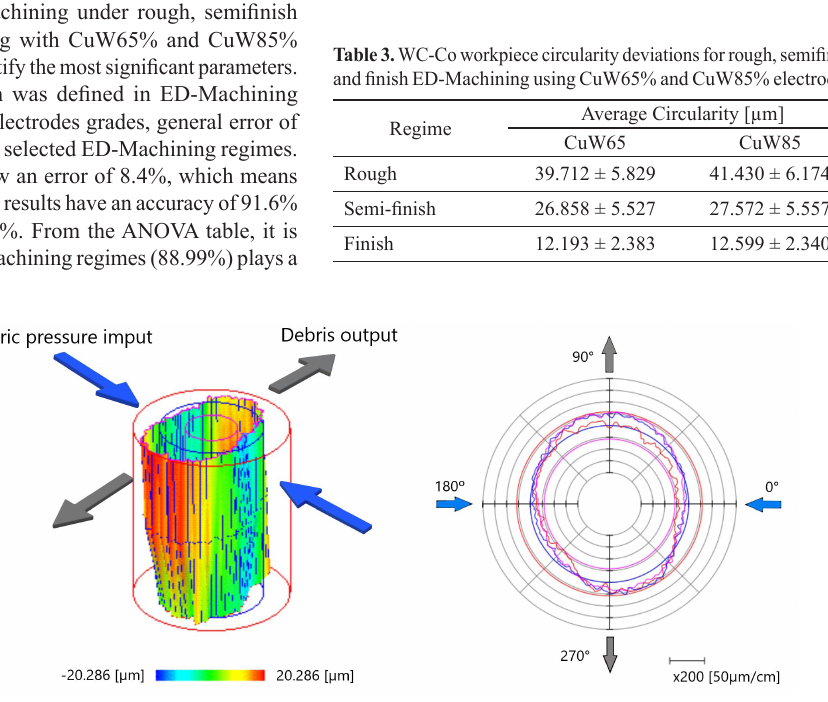
Figure 4. 3D circularity representation for rough EDM regime (i